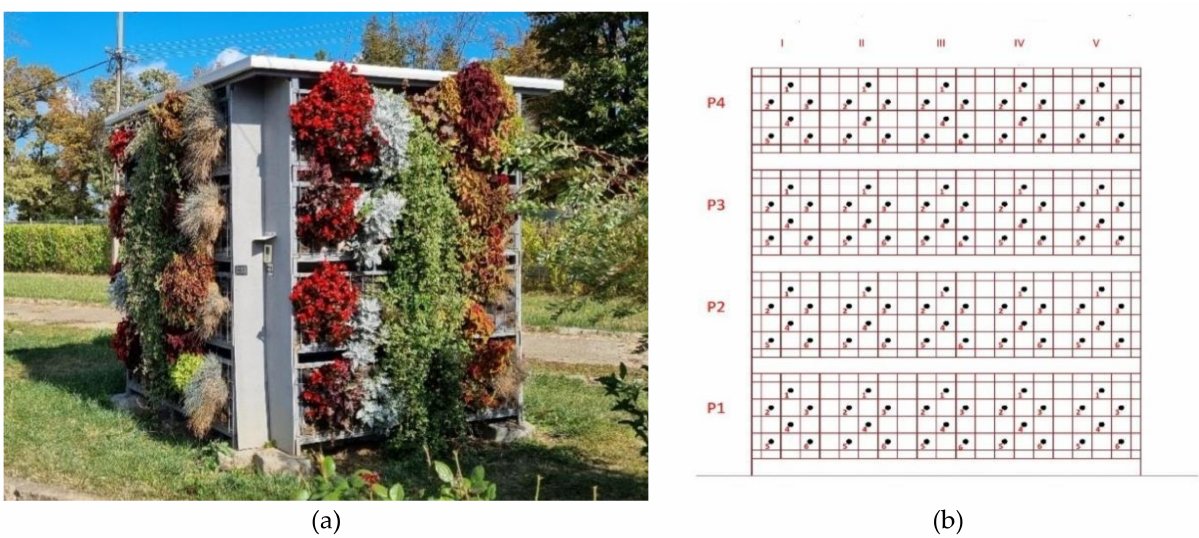
Figure 1. The experimental module. ( a ) West and south façades in October 2021. ( b ) Planting pattern.